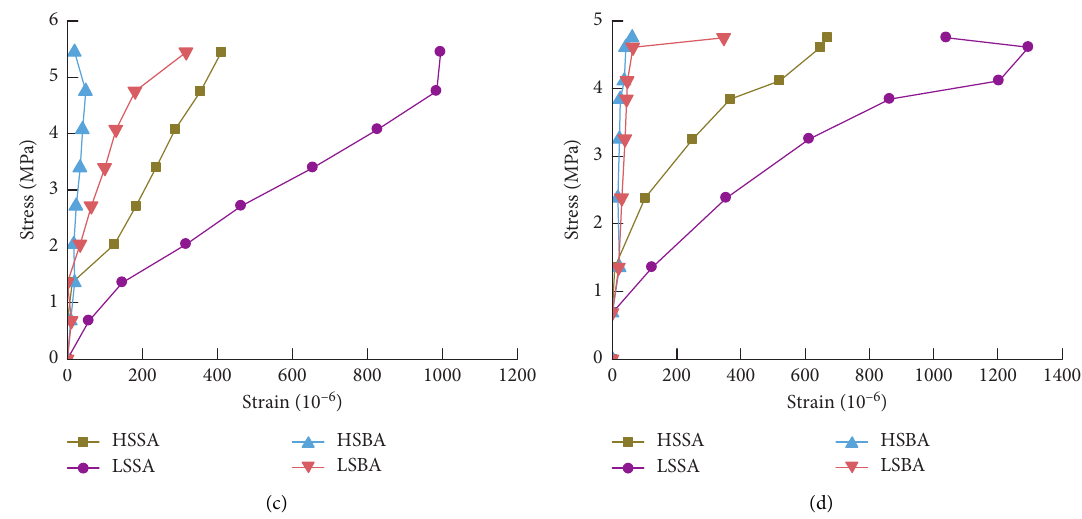
Figure 14: Stress-strain curve of the surrounding rock at the corner of the roadway. (a) 18 ° . (b) 21 ° . (c) 27 ° . (d) 27 ° .